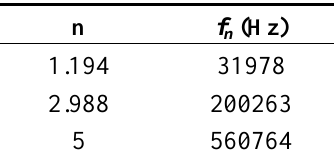
Table 1. n values and the resonant frequencies f Equation